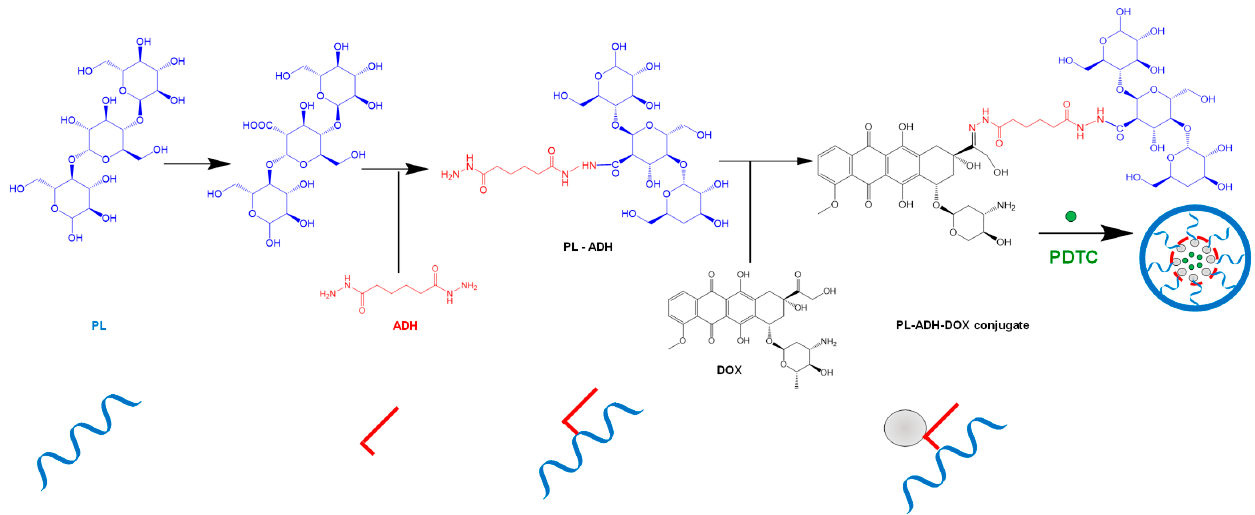
Figure 10. Doxorubicin–PDTC co-loaded nanoparticles. Adapted from [178], published by J Mater Chem B, 2015. ADH—adipohydrazide; DOX—doxorubicin; PDTC—pyrrolidine dithiocarbamate; PL—pullulan.